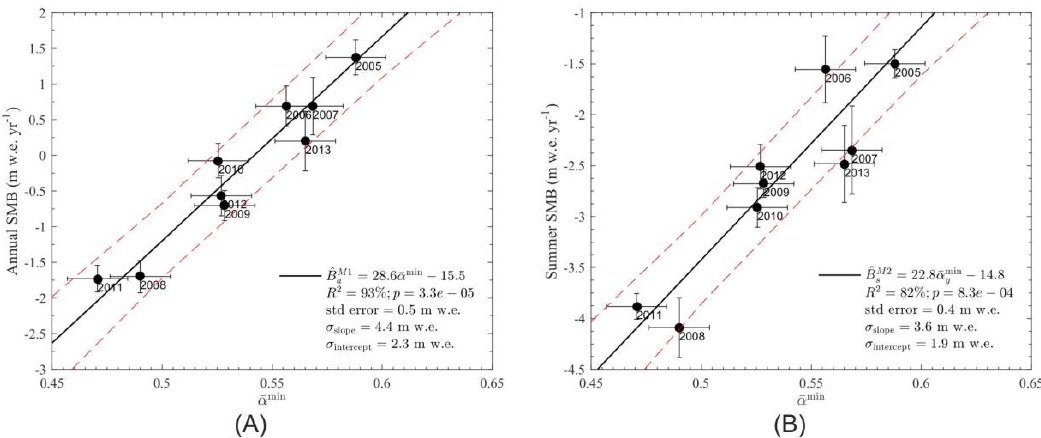
Figure 3. Relationships between ( A ) annual and ( B ) summer surface mass balance (SMB) and minimum glacier-wide albedo calculated across 26 MODIS pixels on Brewster Glacier (from [42]).